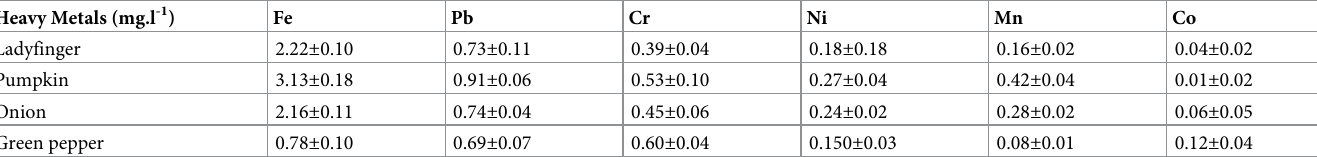
Table 5. Concentrations of heavy metals (mg.l -1 ) in vegetables irrigated with TWW. Heavy Metals (mg.l -1 )